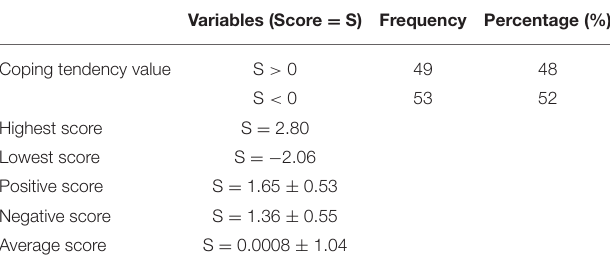
TABLE 3 | Simple coping style questionnaire